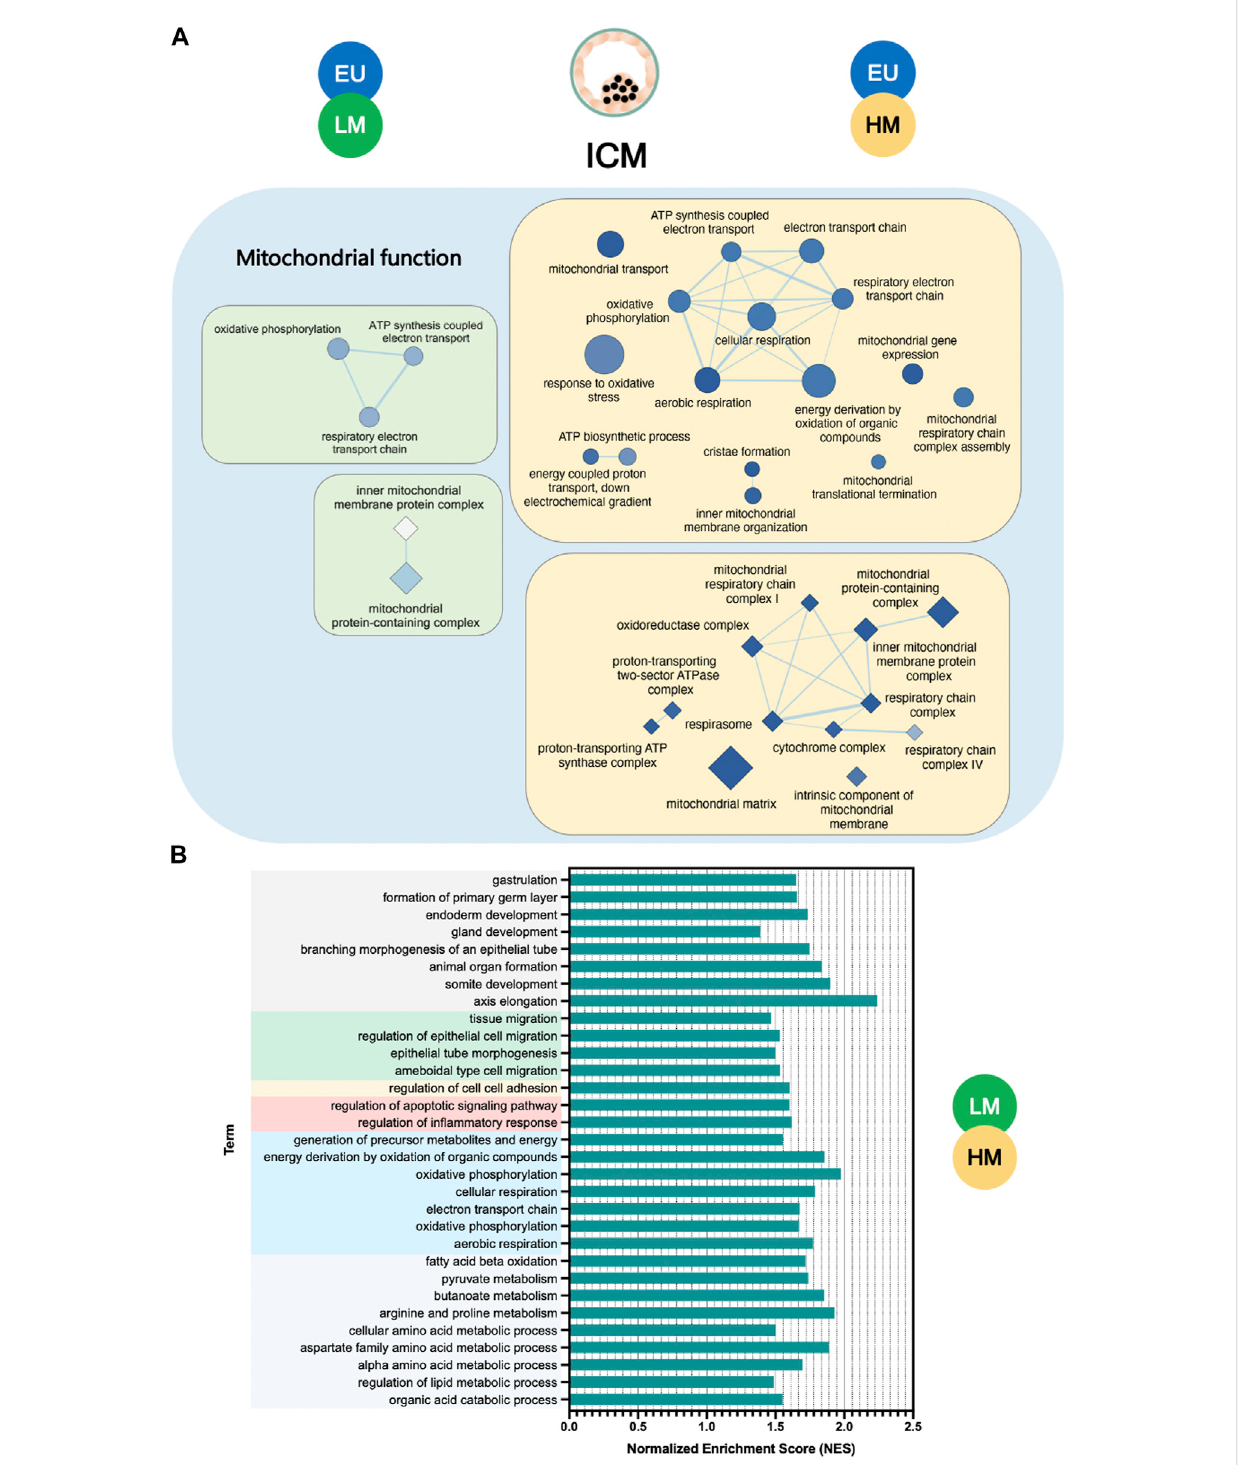
FIGURE 4 Gene set enrichment analysis of inner cell mass samples. (A) Enrichment map of mitochondrial terms signi fi cantly downregulated in the inner cell mass (ICM) of low-level mosaic embryos (LM) (green panels) and high-level mosaic embryos (HM) (yellow panels) compared to the ICM of euploid (EU) embryos. Nodes represent gene ontology (GO) biological processes (ellipse shape) and cellular components (diamond shape). Node color intensity correlates with the FDR q-value, the more intense the greater statistical signi fi cance of the difference of expression. Node size represents the numberofgenesinthegeneset.Edgesrepresentoverlapbetween genesets,andedgewidthrepresentsthenumberofgenesthatoverlap. (B) Biological processes and pathways signi fi cantly upregulated in the ICM of LM compared to the ICM of HM. KEGG: Kyoto Encyclopedia of Genes and